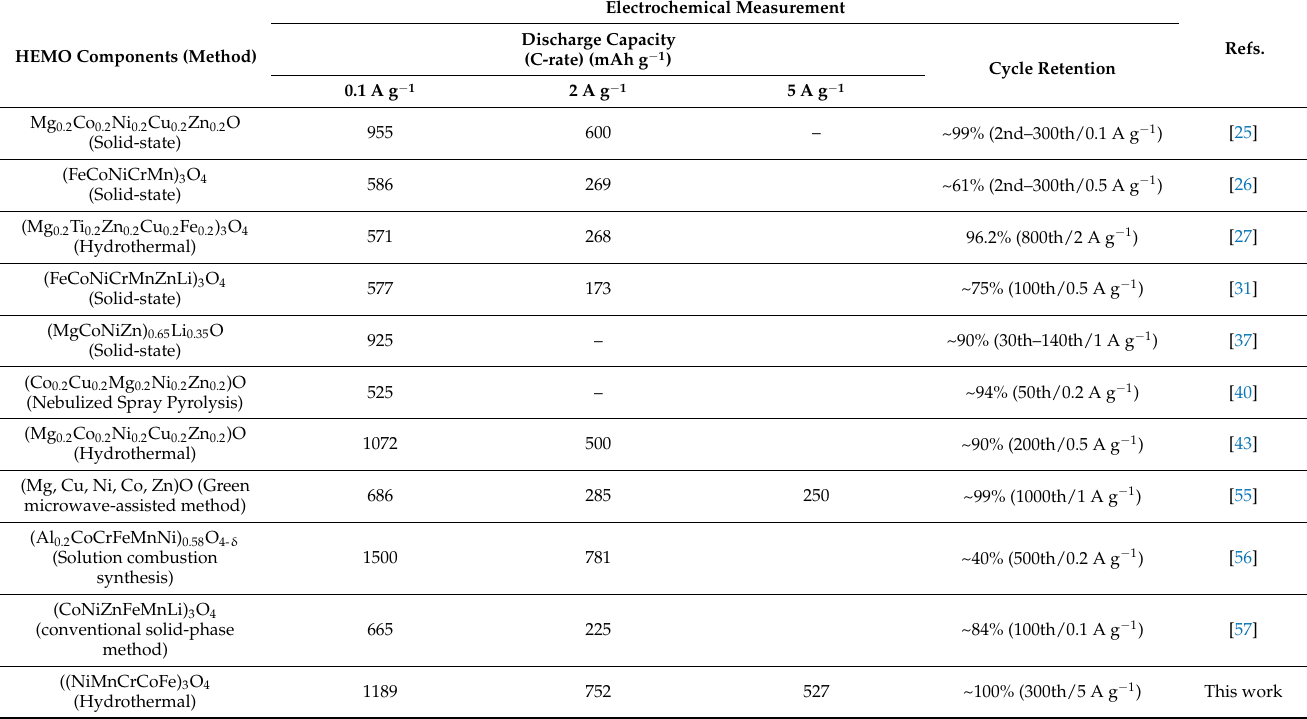
Table 3. Comparison of the electrochemical energy-storage performance achieved in this study with that of previously published work on different high-entropy metal oxide anode materials for